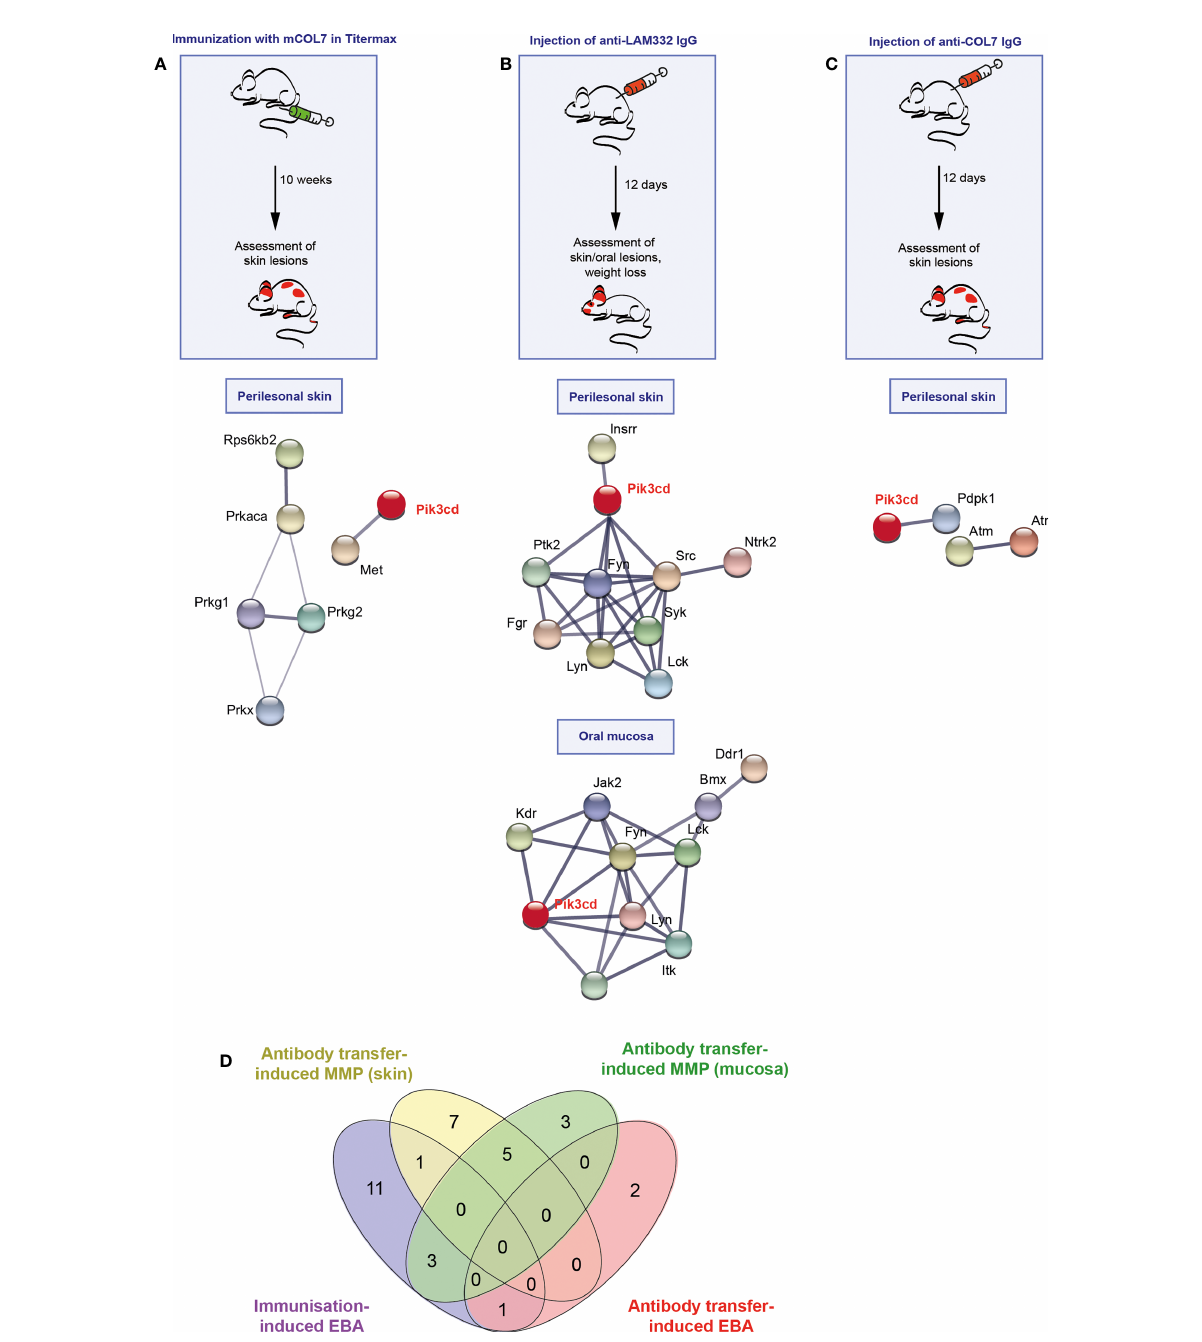
FIGURE 1 Different kinase pathways are activated in experimental models of pemphigoid diseases (PD). (A) For induction of immunization-induced epidermolysis bullosa acquisita (EBA), B6.s mice were immunized with 120 m g of vWFA2 domain of mCOL7 emulsi fi ed (1:1) in Titermax ™ and lesional skin was taken for kinome analysis in comparison to skin of mice treated with Titermax ™ only. Hence, the data shown indicates differences between the samples. (B) To induce experimental mucous membrane pemphigoid (MMP), C57BL/6J mice were injected every other day with 6 mg of rabbit anti-mLAM a 3 IgG or NR IgG for a total of 12 days. (C) Antibody transfer-induced EBA was induced by six injections of 3 mg rabbit anti-mCOL7 IgG or (normal rabbit) NR-IgG for a total of 12 days. In all three models, treatment regimens and STRING database analysis of kinases that are modulated are depicted here for analysis of perilesional skin and (MMP model only) oral mucosa. STING interaction modules are shown at the medium con fi dence level. Thickness of the lines indicates the strength of the predicted interaction. Colors of kinases are randomly selected. Differently activated kinases that did not have any connections to other kinases were excluded from the networks. n=3/ model and group. (D) Venn diagram of overlapping kinase pro fi les in the respective PD